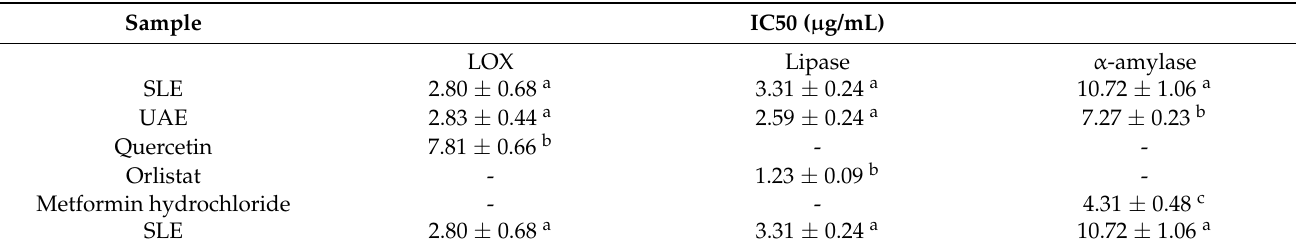
Table 3. The enzyme inhibition results (IC50 values; µ g/mL) of SLE and UAE selected extracts in LOX, lipase, and α -amylase